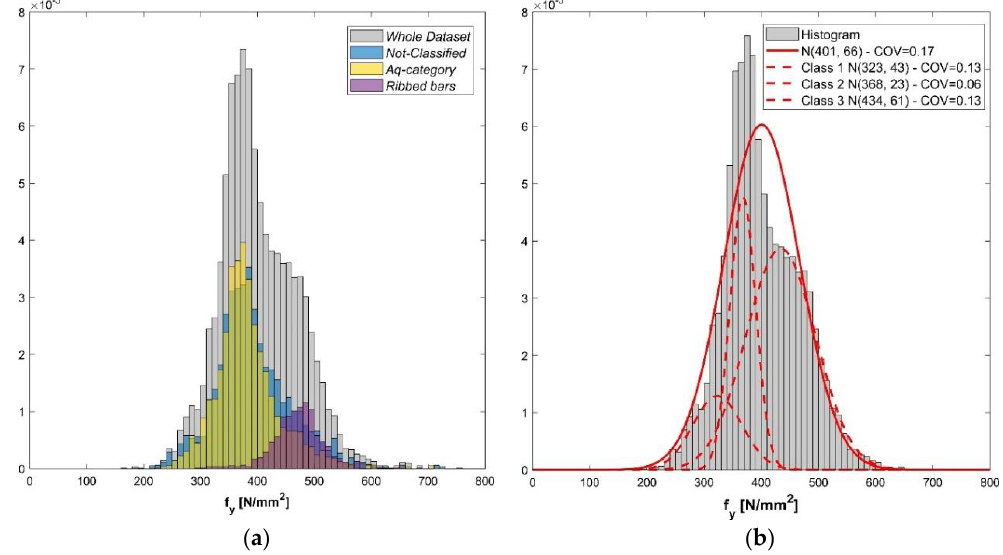
Figure 4. ( a ) Bar charts of yielding strength of steel rebars for the whole dataset and the sub-divisions of “ Not classified steel ”, “ Aq-category ” and “ Ribbed bars ”; ( b ) results of the cluster analysis for yielding strength f y and identification of three different sub-classes.